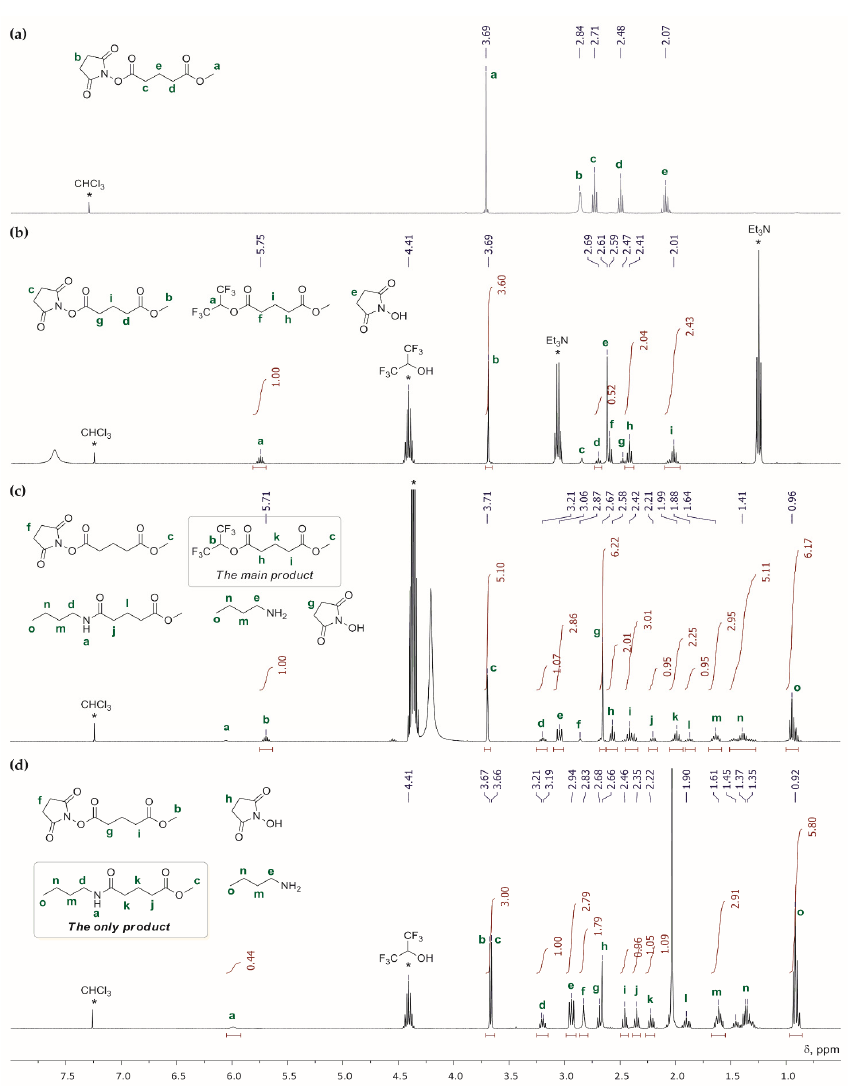
Figure 1. 1 H NMR spectra (400 MHz, CDCl 3 , 20 °C) of ( a ) NHS-OMe (reference); ( b ) NHS-OMe + HFIP in the presence of Et 3 N after 1 h; ( c ) NHS-OMe + HFIP + n -BuNH 2 after 3 h; and ( d ) NHS-OMe + HFIP + n -BuNH 2 in the presence of AcOH after 3 h.